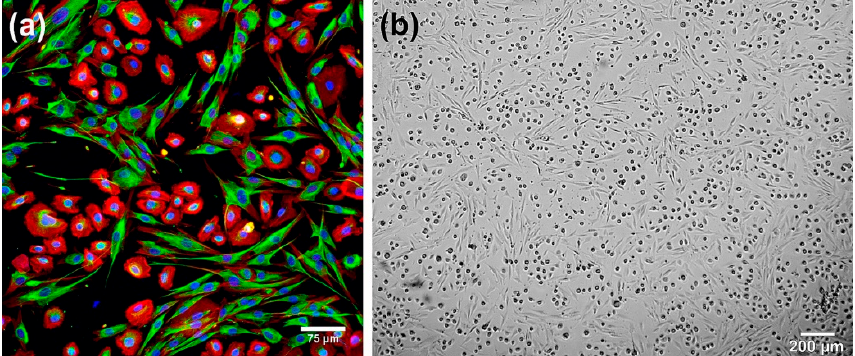
Figure 6. Co-culture of human skin fibroblasts and keratinocytes: ( a ) CLSM image (fibroblasts show blue fluorescence of nuclei, red fluorescence of actin filaments, and green fluorescence of vimentin filaments, whereas keratinocytes show blue fluorescence of nuclei and red fluorescence of actin filaments); ( b ) phase-contrast image showing co-culture of skin cells (fibroblasts reveal spindle-shaped morphology, whereas keratinocytes are visible as round cells).